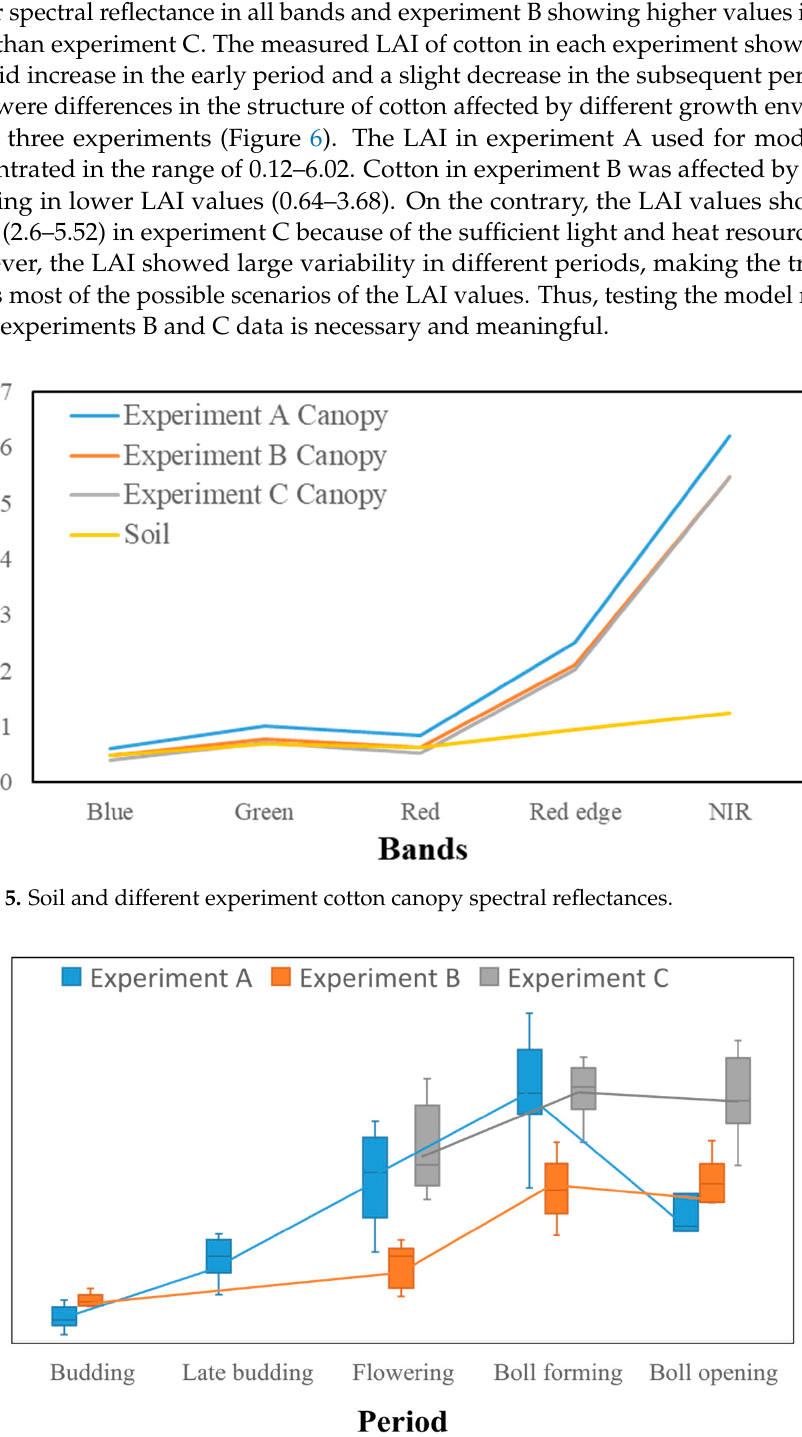
Figure 6. Measured values of cotton ground plots at different periods in different experiments.